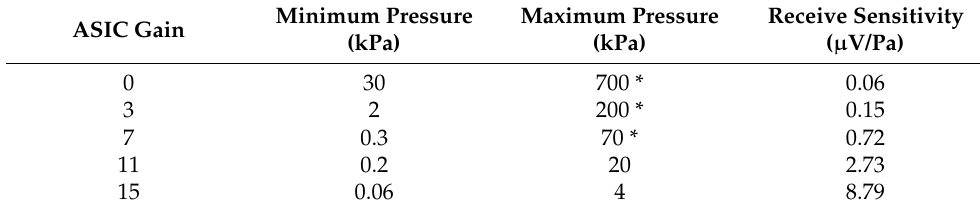
Table 3. Receive performance for different gain settings. ASIC